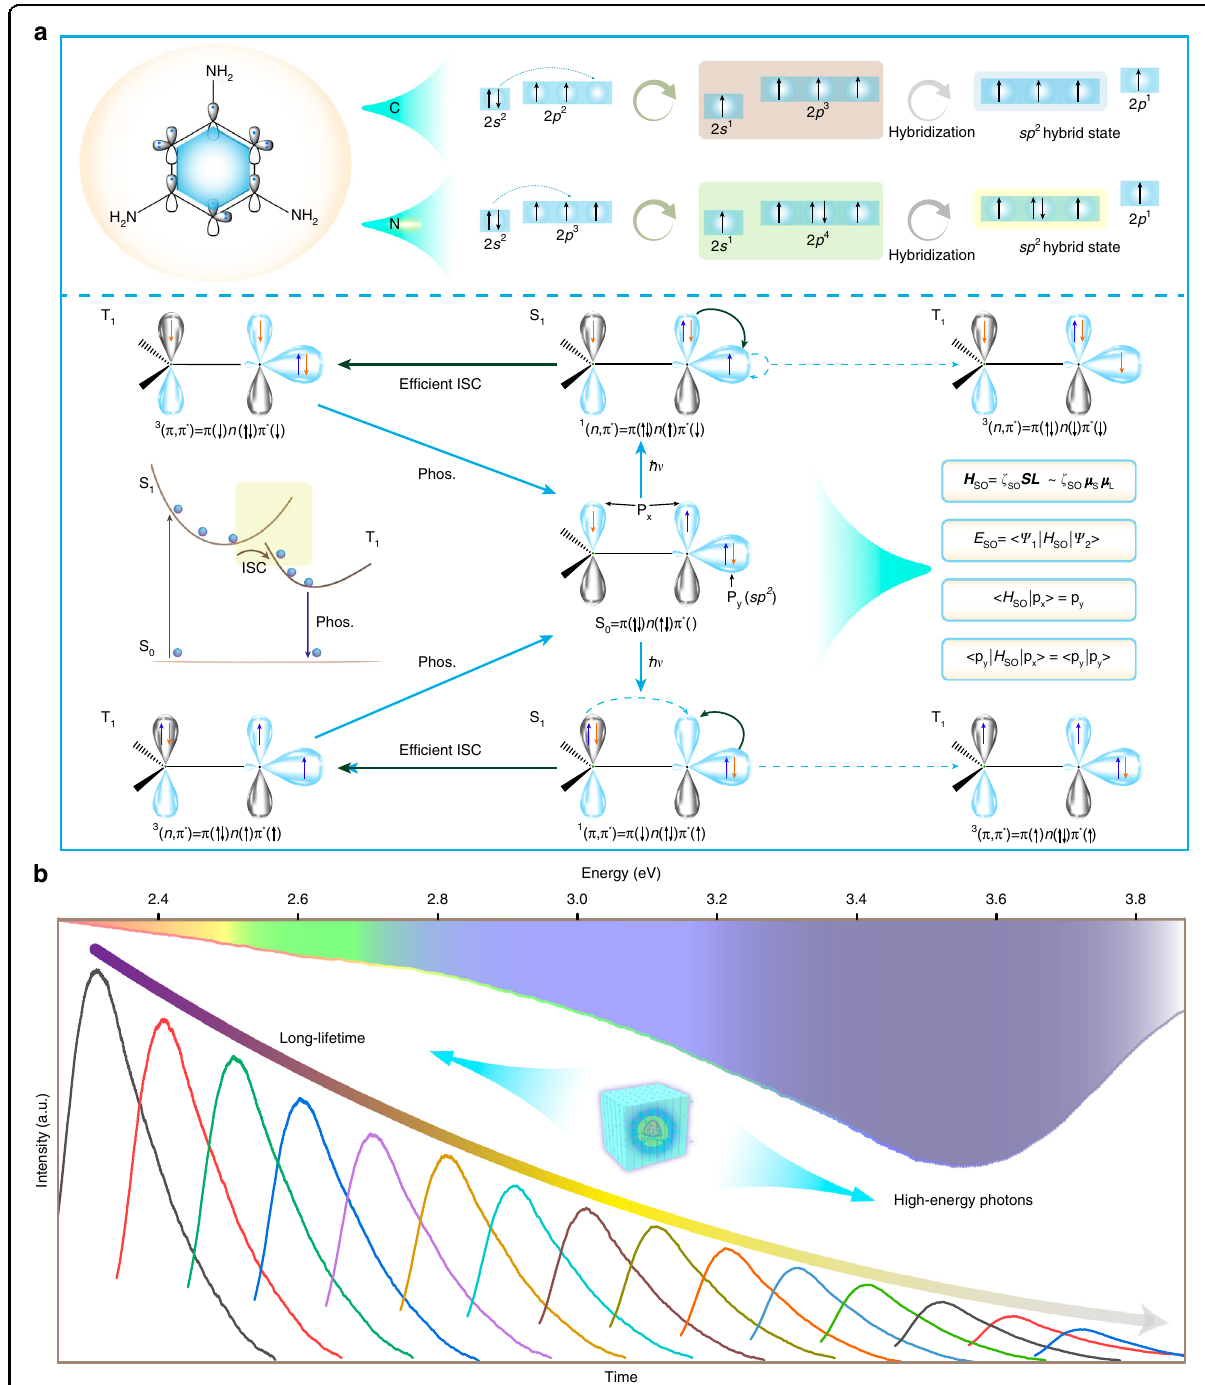
Fig. 1 Schematic illustration for achieving UV phosphorescence in CNDs. a Molecular structural unit and electron orbitals of the C and N atoms in CNDs. Schematic illustration of the El-Sayed rule and the corresponding phosphorescence decay process. b Phosphorescence energy spectra and photoluminescence lifetime decay of the UV phosphorescent